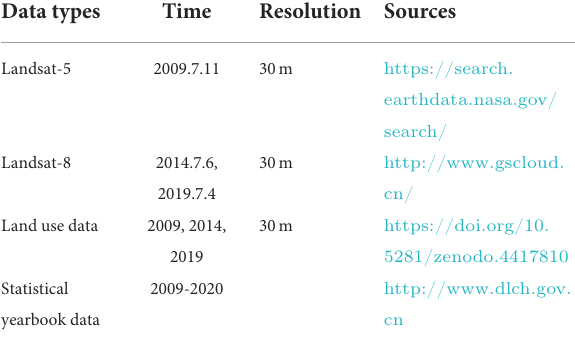
TABLE 1 Data types and